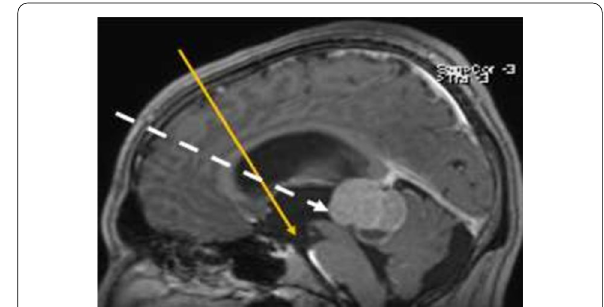
Fig. 1 Preoperative sagittal T1 MRI with contrast showing the trajectory for an ETV (yellow arrow) and the trajectory for pineal region tumor biopsy (white dotted